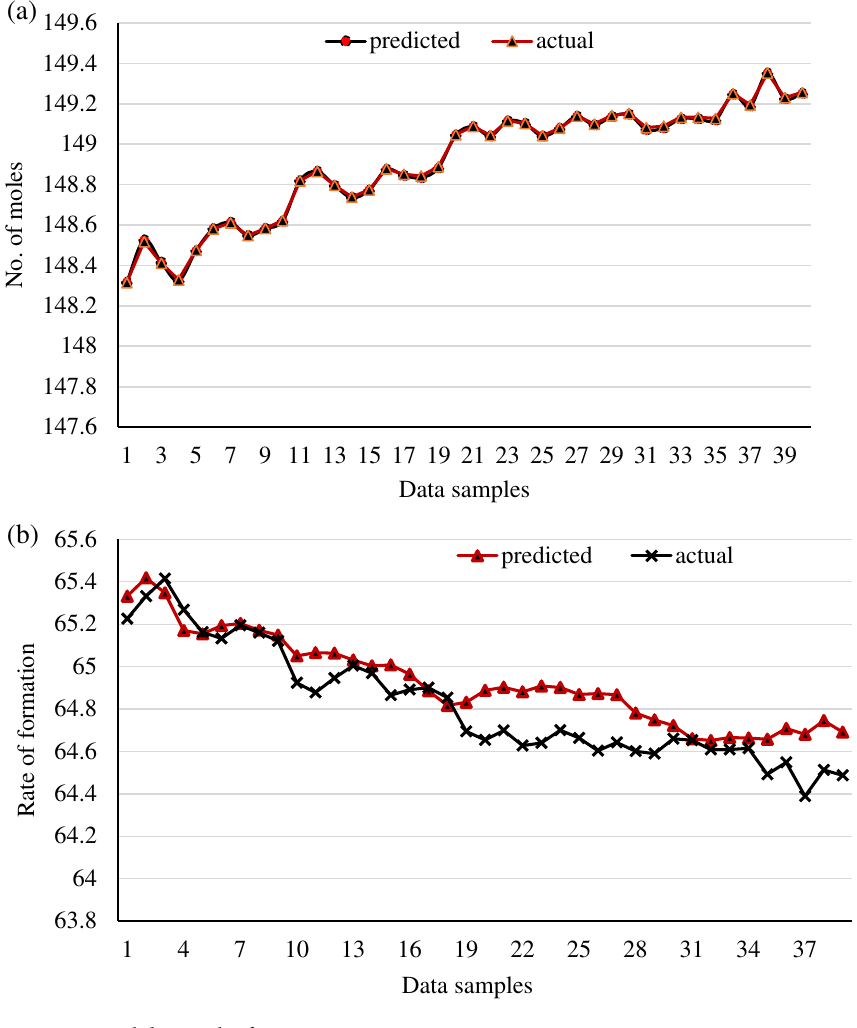
Figure 15. Validation plot for gas + CO 2